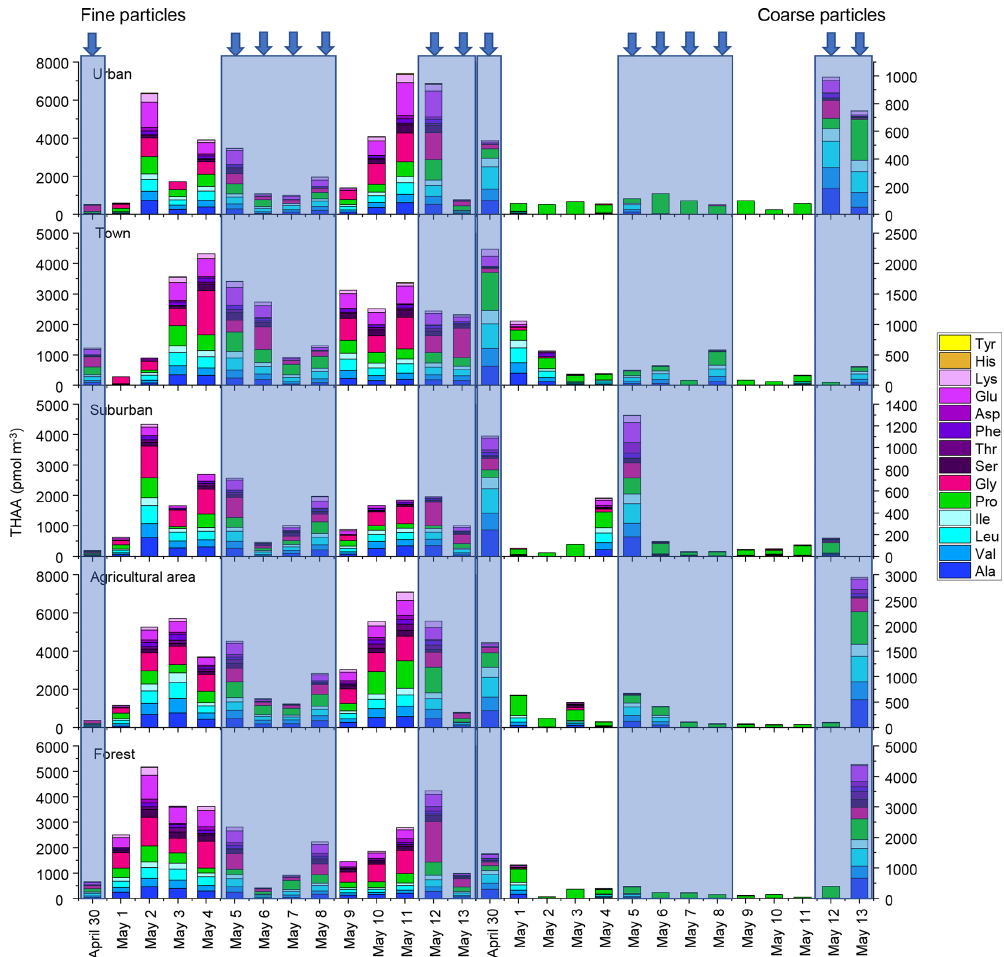
Figure 1. Concentrations of hydrolyzed amino acids for fine and coarse particles in urban, town, suburban, agricultural and forest sites during 14 consecutive sampling days. The concentrations of HAAs for each sample were normalized for the total volume of air sampled. The blue arrow and shallow represent